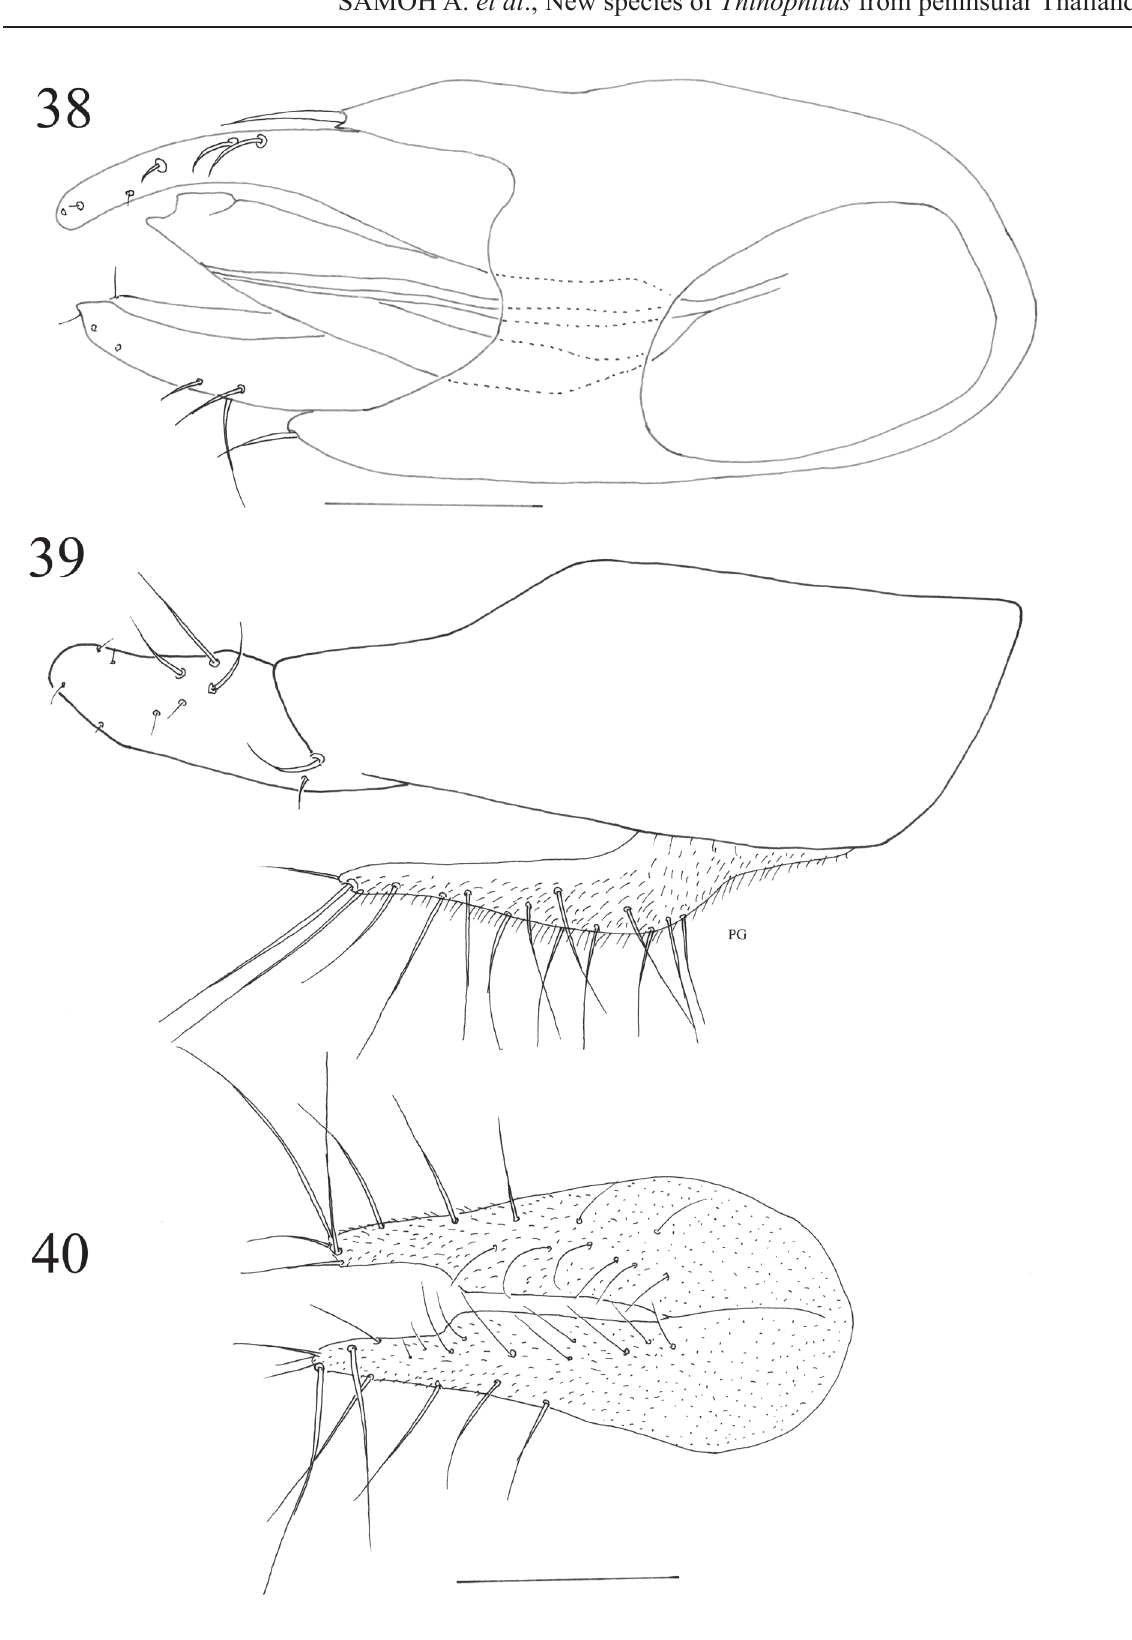
Figs 38–40. Thinophilus variabilis sp. nov., ♂, terminalia. 38 . Genital capsule, ventral view. 39 . Genital capsule, lateral view. 40 . Cerci, dorsal